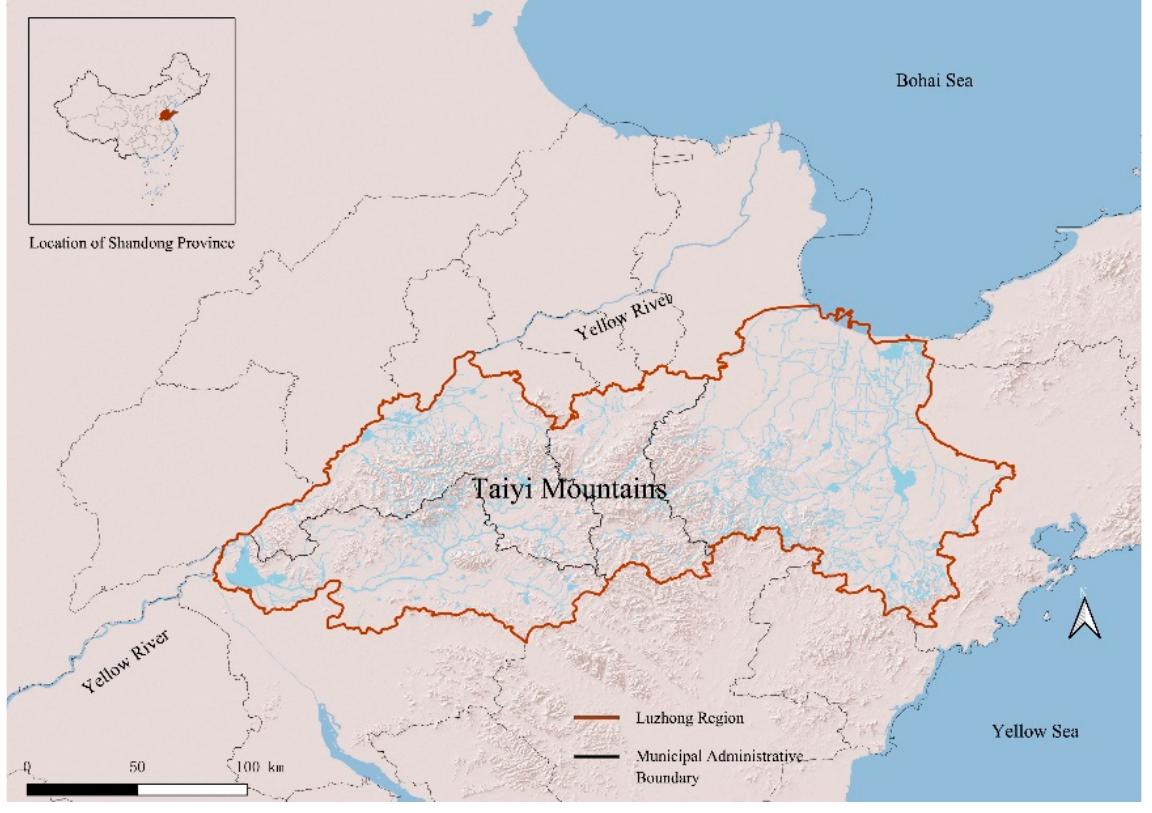
Figure 1. Location and scope of the Luzhong region.